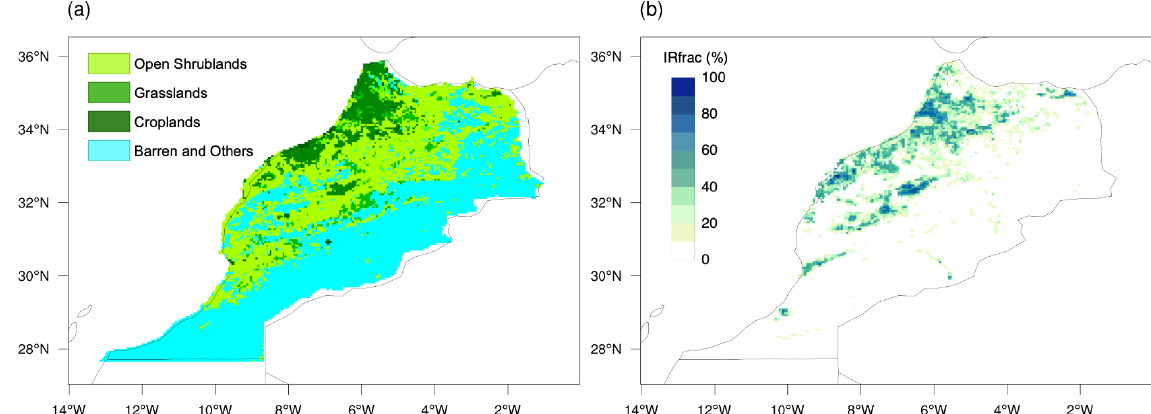
Figure 1. Map of (a) the major land cover types based on MODIS International Geosphere Biosphere Programme (IGBP) data set and (b) the composite irrigation fraction intensity for Morocco.